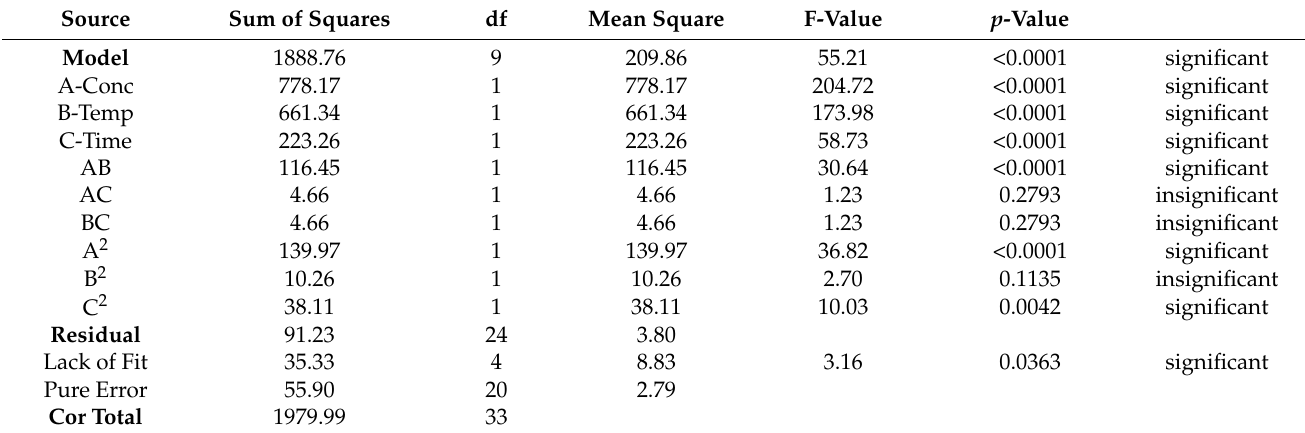
Table 6. ANOVA for Dy Extraction.